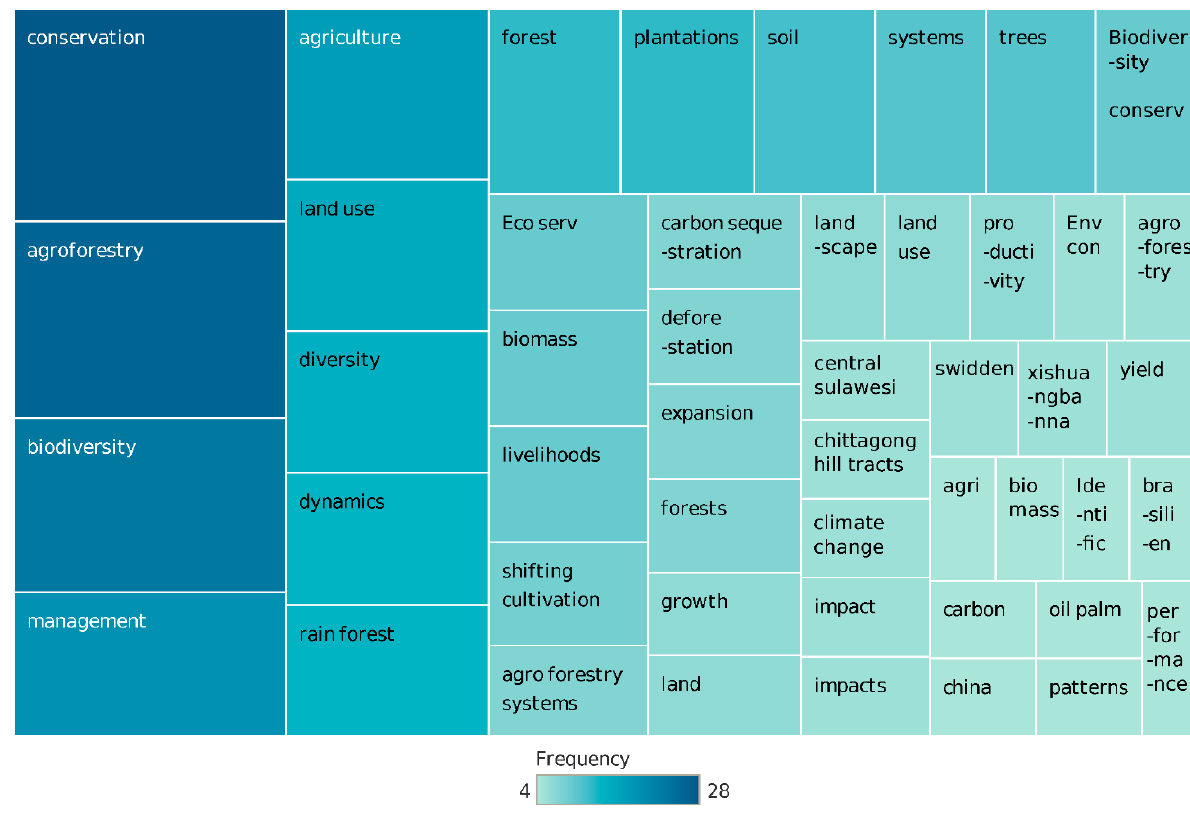
Forests 2021 , 12 , x FOR PEER REVIEW Figure 1. Word tree-map of most frequently used keywords with reference to agroforestry in south Asia.